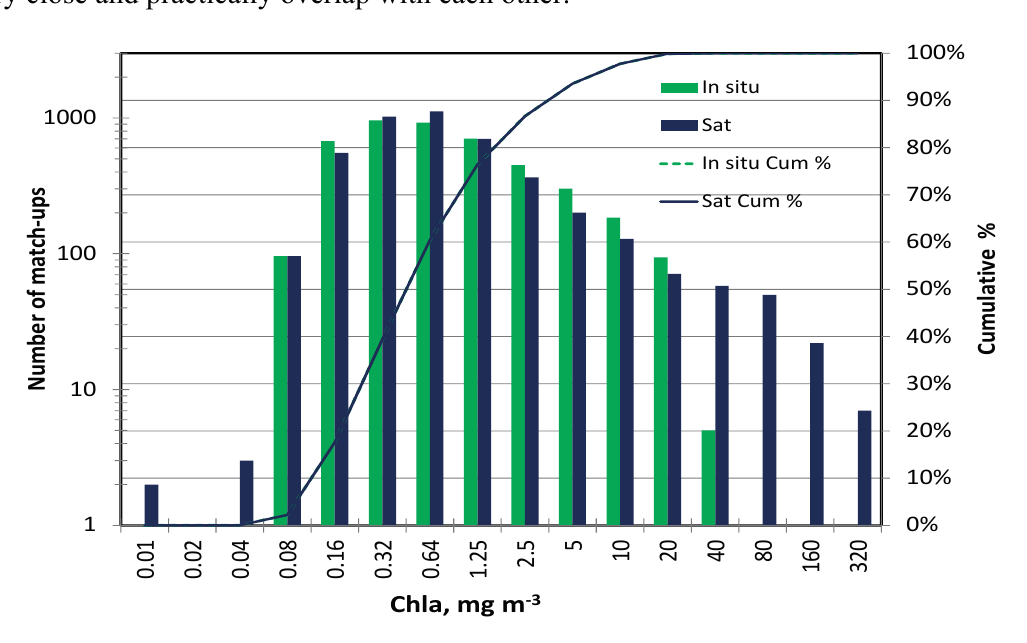
Figure 2. Histograms of in situ Chla and MODISA-derived Chla in match-ups with up to a five-day time difference. The full range is 0.02–47 mg m − 3 for in situ and 0.01–249 mg m − 3 for the satellite retrievals (the mean of the valid pixels). The cumulative histograms are very close and practically overlap with each other.